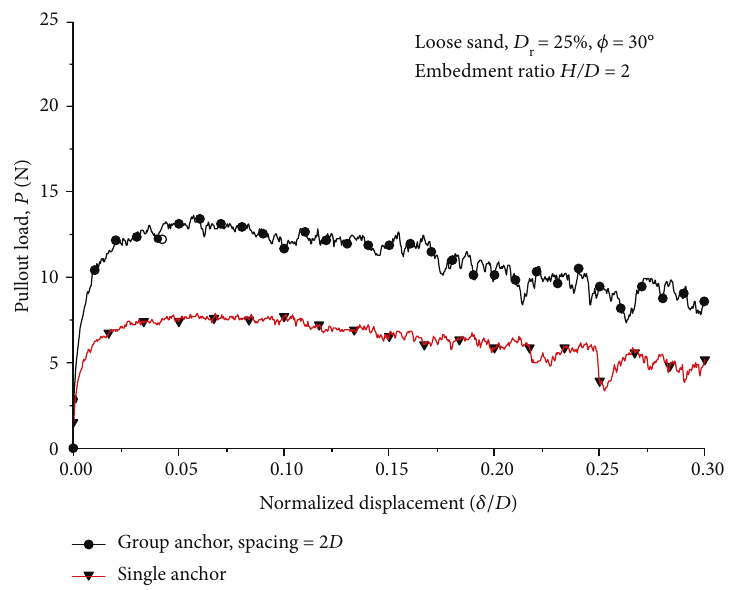
Figure 2: Pullout load – displacement curves for two-plate group anchors with H / D = 2 in loose